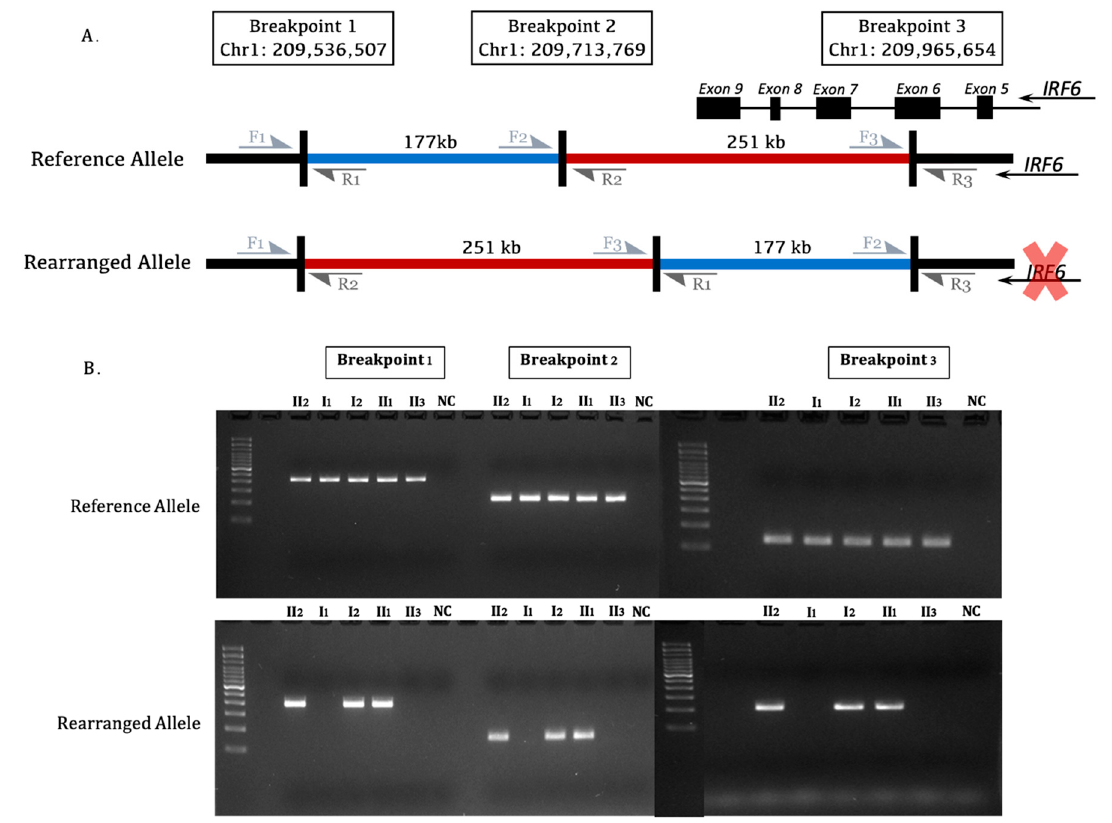
Figure 4. ( A ) Diagram showing the rearrangement event occurring in affected family members where the red and blue regions are switched disturbing the continuity of IRF6 exon 6; ( B ) Gel electrophoresis of PCR products (100 bp ladder used) from the reference and rearranged alleles. All family members had the reference allele, while only the affected family members had the rearranged allele. F1/R1, F2/R2, and F3/R3 are the 3 primer sets (Forward and reverse) designed around the breakpoints.